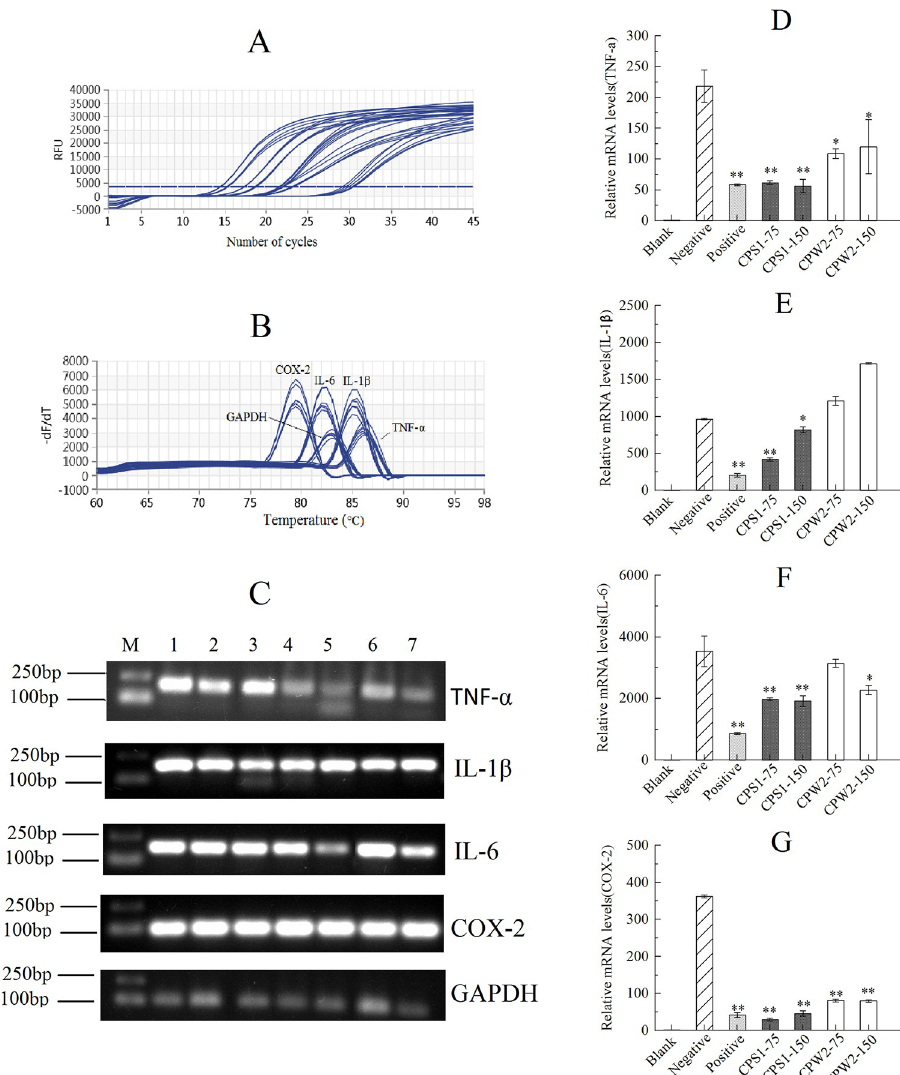
Fig 7. Amplification. (A) and melting peak curves (B) of genes for CPS1 and CPW2. Electrophoresis diagrams of amplified genes (C) (M: D15000+2000 Marker, 1–7: Blank, negative, positive, CPS1-75, CPS1-150, CPW2-75, and CPW2-150 groups, respectively). TNF- α (D), IL-1 β (E), IL-6 (F) and COX-2 (G) mRNA expressions in LPS-stimulated RAW264.7 mouse macrophage cells (compared with the negative control, * P < 0.05; ** P < 0.0001). Each data point represents the mean ± SD ( n =